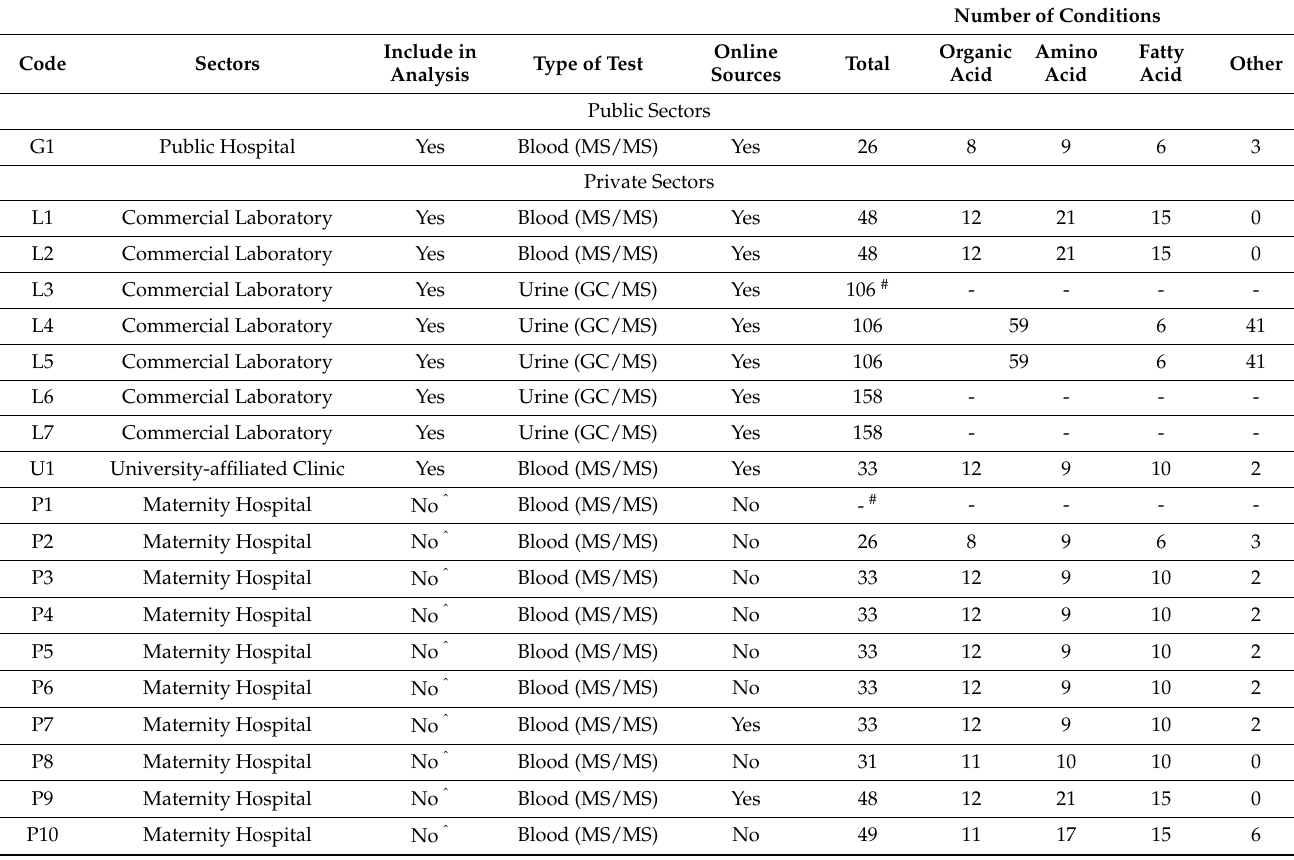
Table 2. Summary of Newborn IMD Screening by